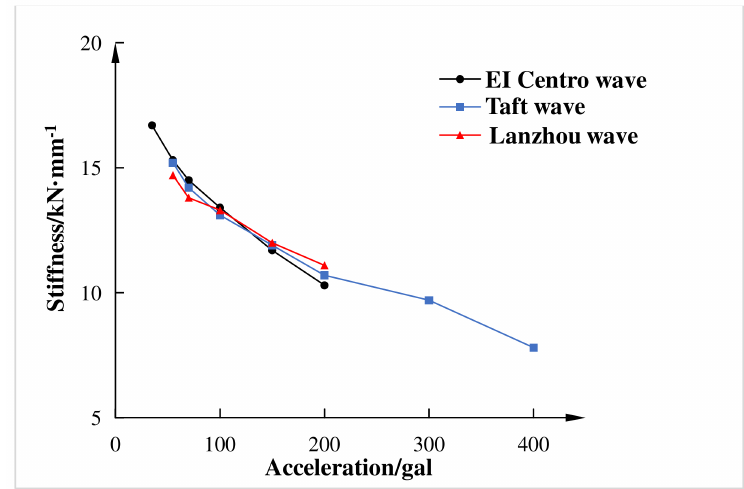
Figure 16. Stiffness degradation curve of model structure.